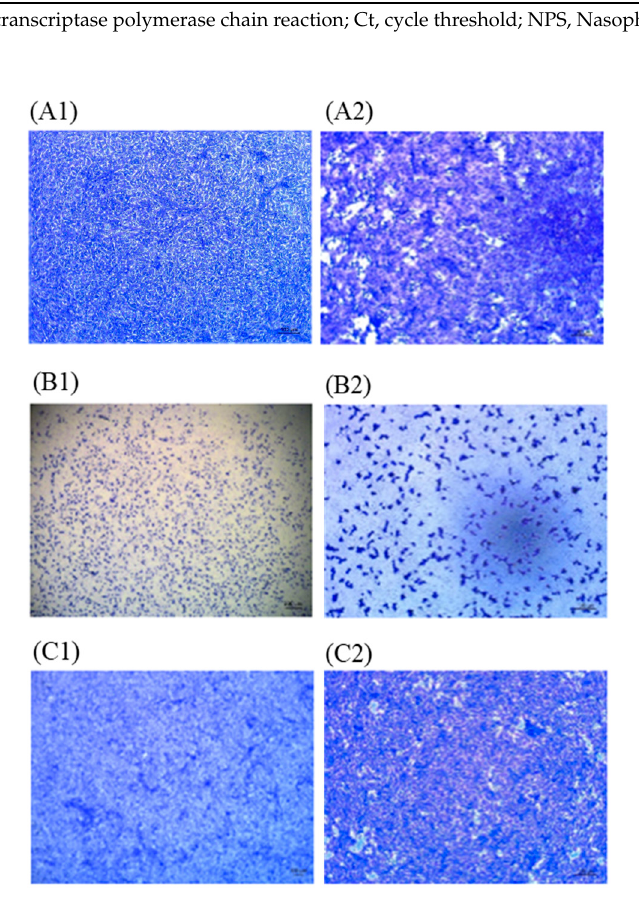
Table 3. Clinical characteristics and Ct value of patients with positive salivary RT-PCR result.